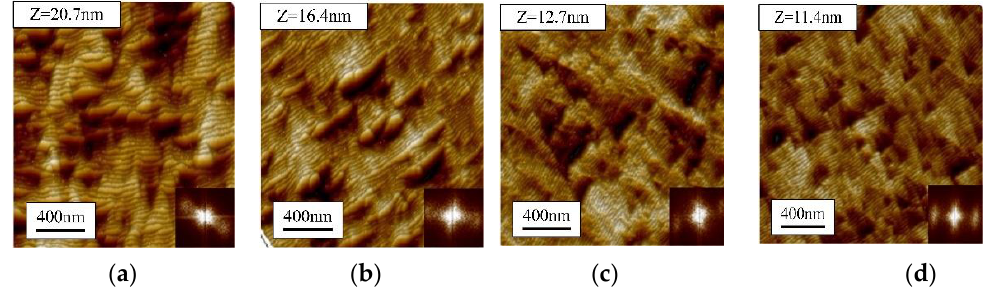
Figure 6. Typical AFM images (2 μ m × 2 μ m) of post irradiated sapphire samples with Fe co-deposition at distances from the Fe target of ( a ) 1 cm, ( b ) 2 cm, ( c ) 3 mm, ( d ) 4 cm, at an oblique angle of incidence 65 ° with constant ion beam current density 487 μ A/cm 2 and the erosion duration of 60 min. Top-left and bottom-right insets show the corresponding longitudinal height and Fourier transform, respectively.